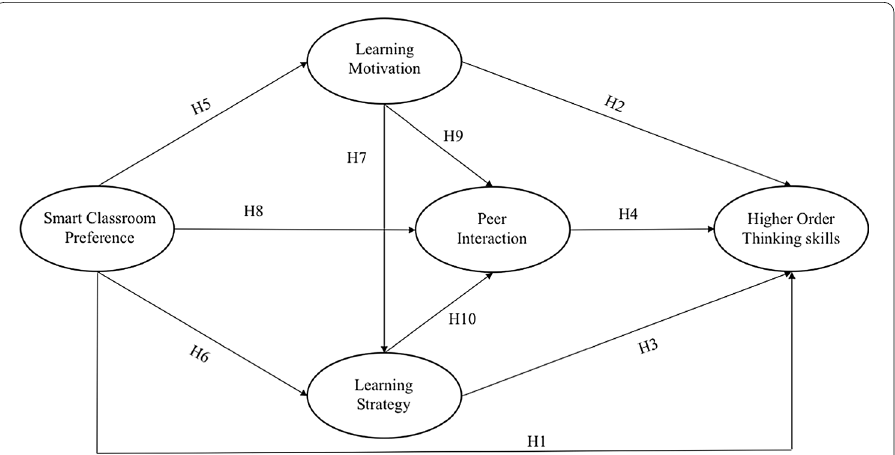
Fig. 1 Proposed research model and